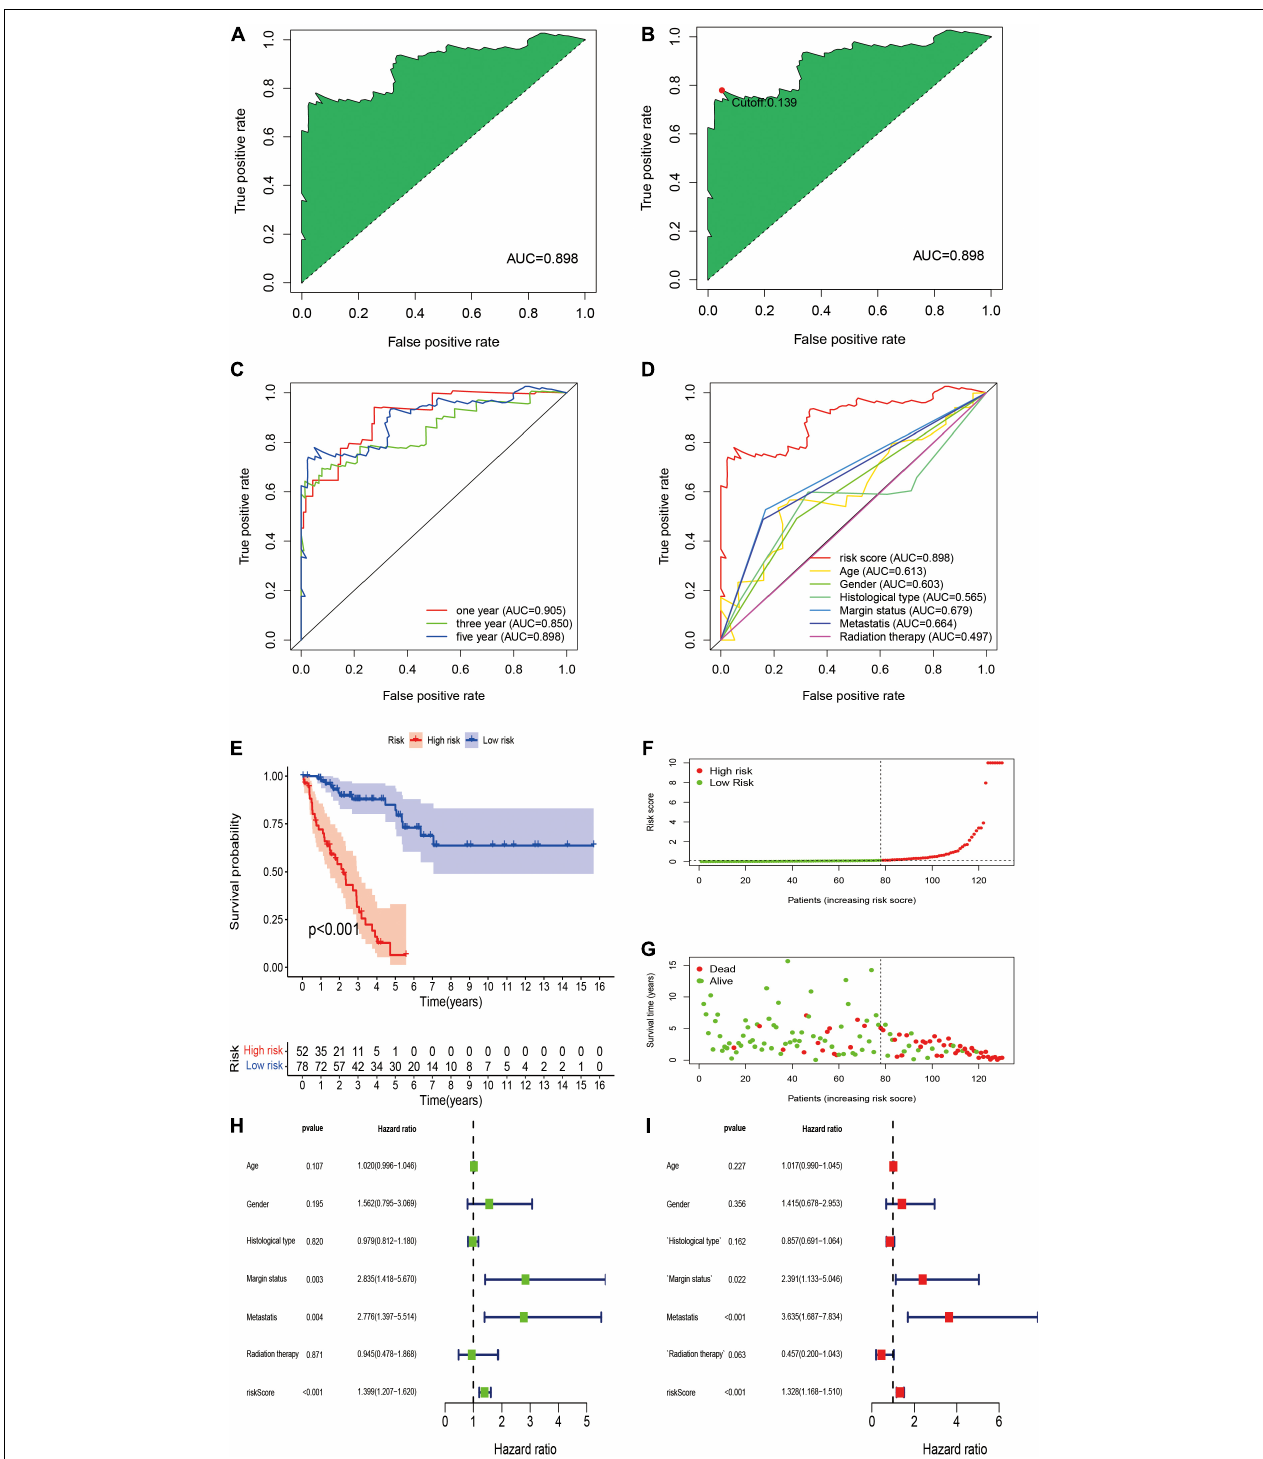
FIGURE 3 | Construction of DEirlncRNA pairs-based risk signature in the training cohort. (A) The ROC of the optimal DEirlncRNA pairs-based risk signature with the highest AUC. (B) Identification of the cut-off point on the ROC curve by the AIC. (C) The 1-, 3-, and 5-year ROC curves of the optimal model. (D) Comparison of the 5-year ROC curve with other clinical characteristics. (E) Kaplan–Meier analysis of patients in the high risk and low risk groups. Patients in the low-risk group experienced a longer survival time. (F,G) Distributions of risk scores and survival status of STS patients. (H,I) Univariate and multivariate Cox regression analyses of clinical factors and prognostic risk signature for overall survival. Univariate and multivariate analyses revealed that risk score was an independent prognostic predictor.